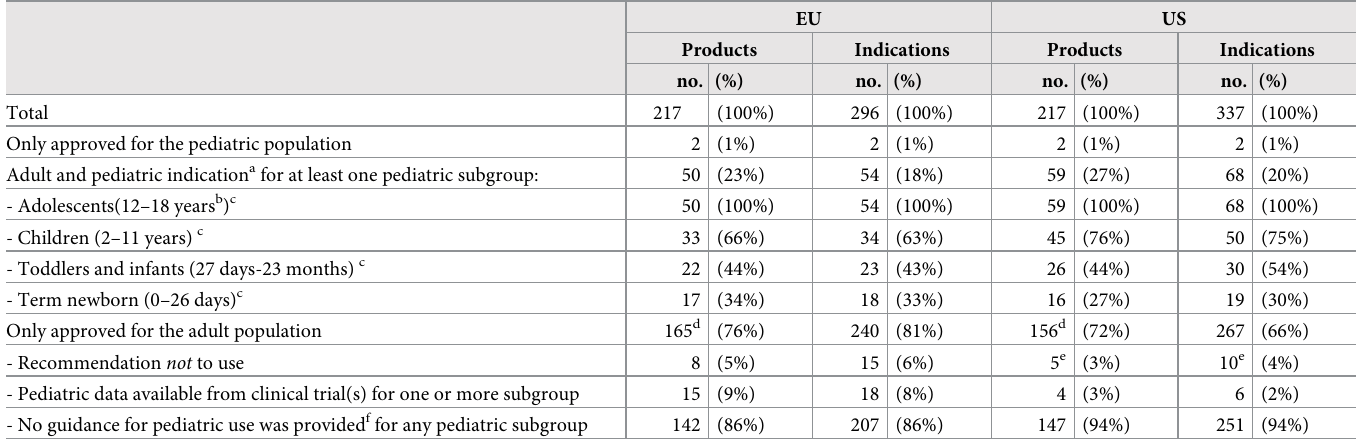
Table 3. Descriptive overview of the approved pediatric indications and pediatric guidance for use by products and indications in the EU and the